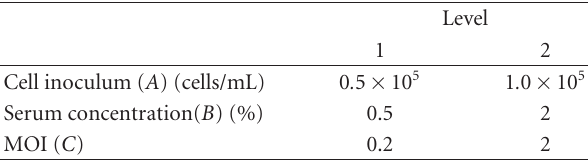
Table 1: The L4 array Taguchi layout.